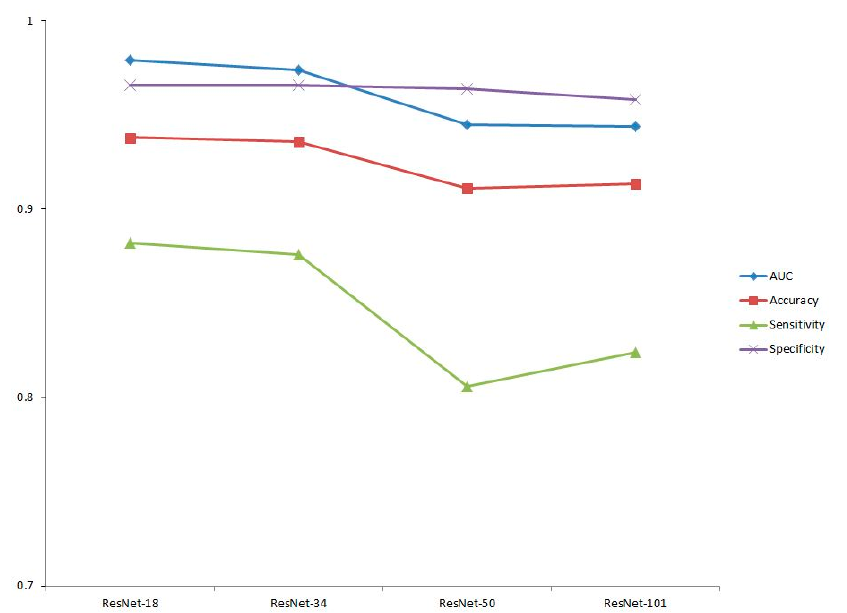
Figure 6. Screening performance of four models: AUC (blue line), accuracy (red line), sensitivity (green line), and specificity (purple line).